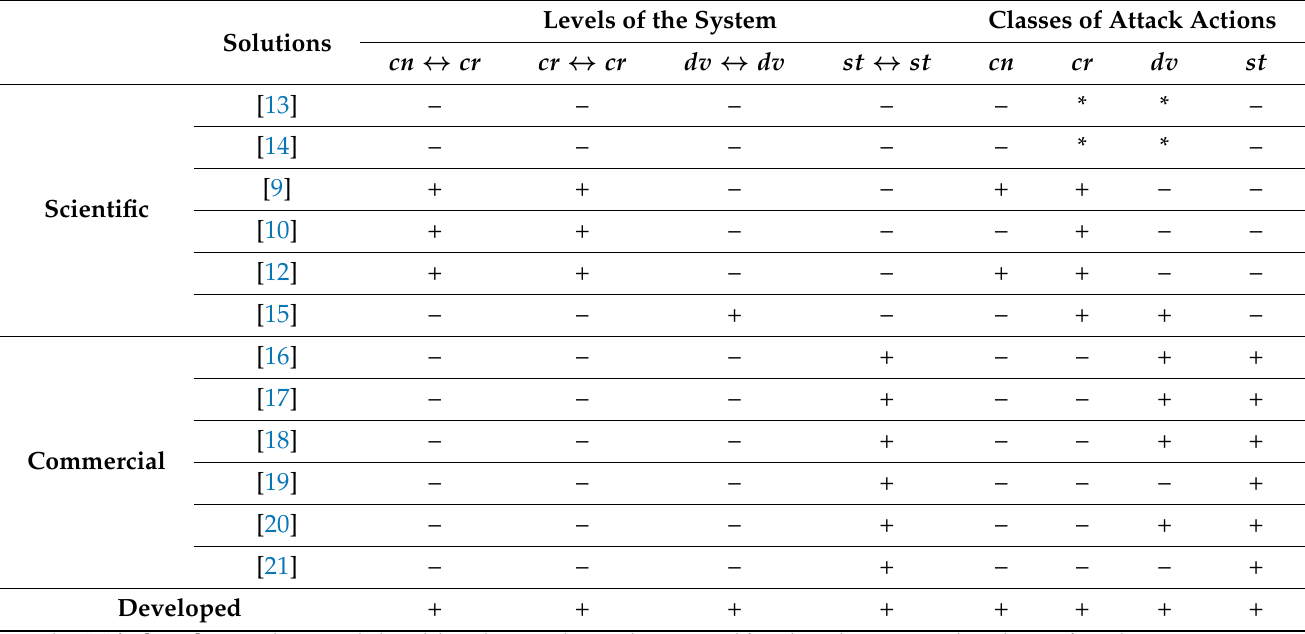
Table 12. The comparison with commercial and scientific